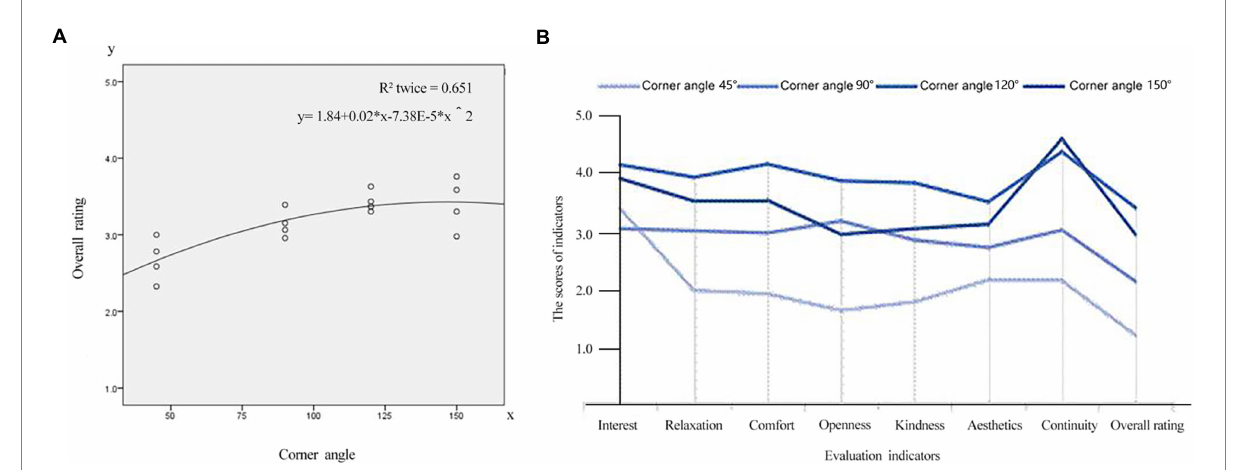
FIGURE 3 Analysis of corner angle compared to overall rating. (A) Scatter plot of overall score against angle. (B) Line chart of angles and evaluation indicators.